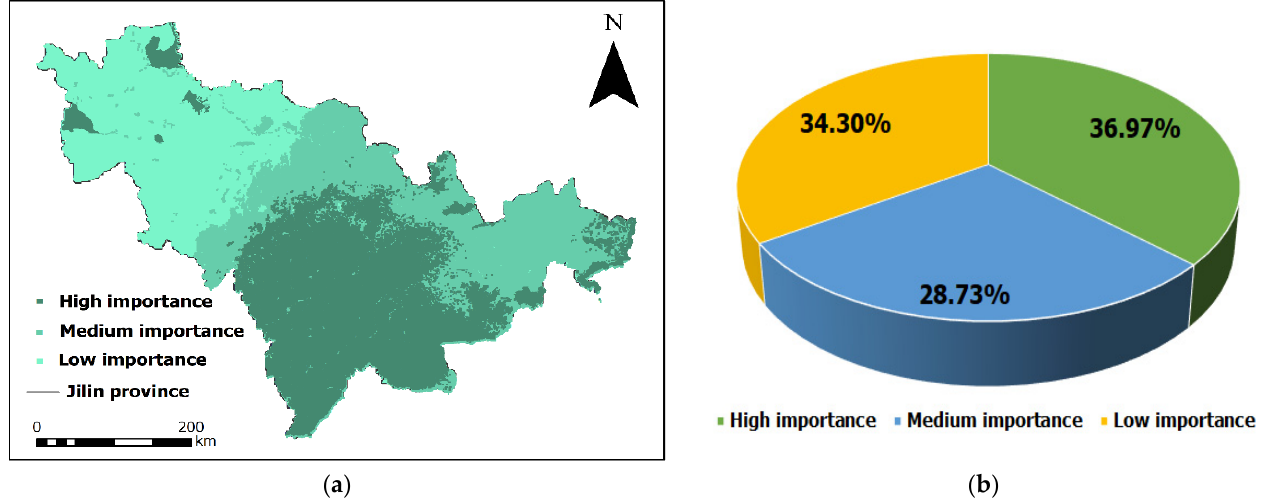
Figure 11. ( a ) Delimitation result of ecological space for water conservation, and ( b ) the proportion of functional areas with different levels of different importance.